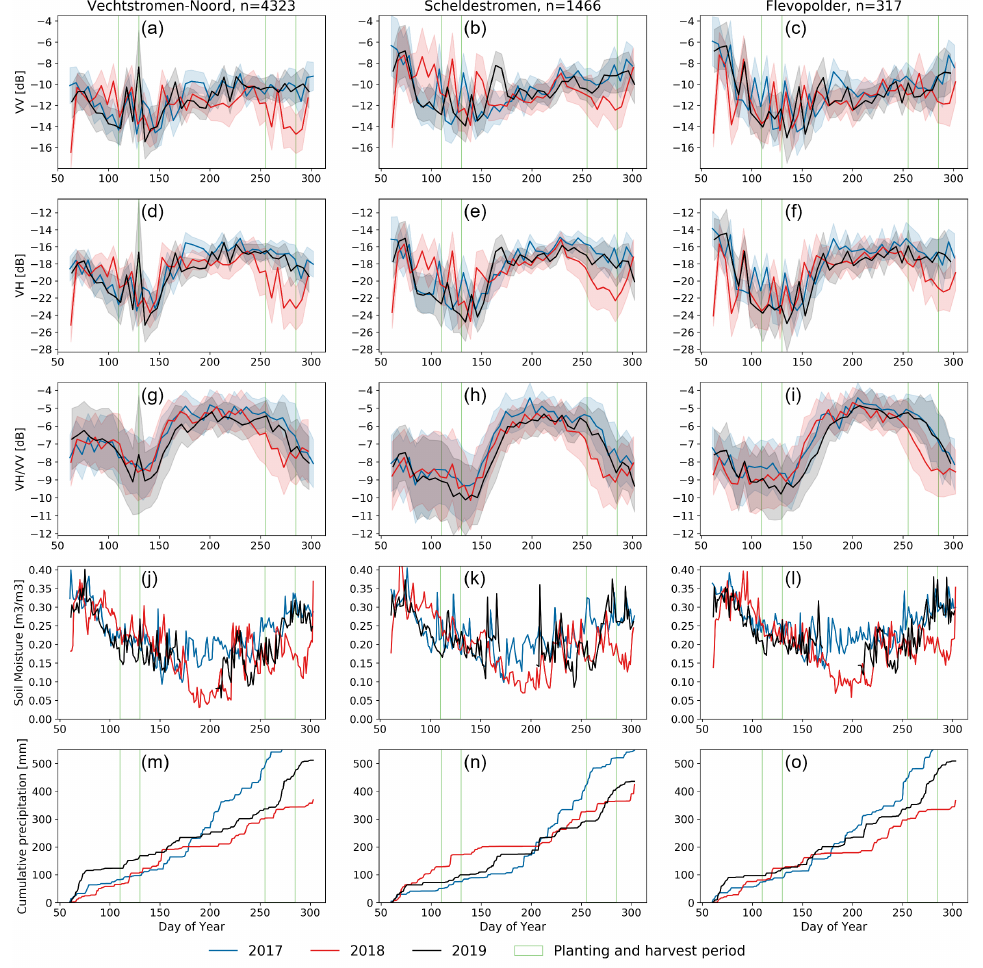
Figure 6. Averaged backscatter profiles of VV ( a – c ), VH ( d – f ) and VH/VV ( g – i ) for maize parcels in Vechtstromen-Noord (left), Scheldestromen (middle) and Flevopolder (right) for the years 2017, 2018 and 2019. The title of the columns states the number of maize parcels in each area. The shaded areas indicate the standard deviation calculated across all parcels. Spatially averaged soil moisture ( j – l ) from Coevorden, Goes and Zeewolde municipalities and cumulative precipitation ( m – o ) from Hoogeveen, Vlissingen and Lelystad weather stations, respectively, for each area. Vertical green lines indicate crop sowing and harvesting